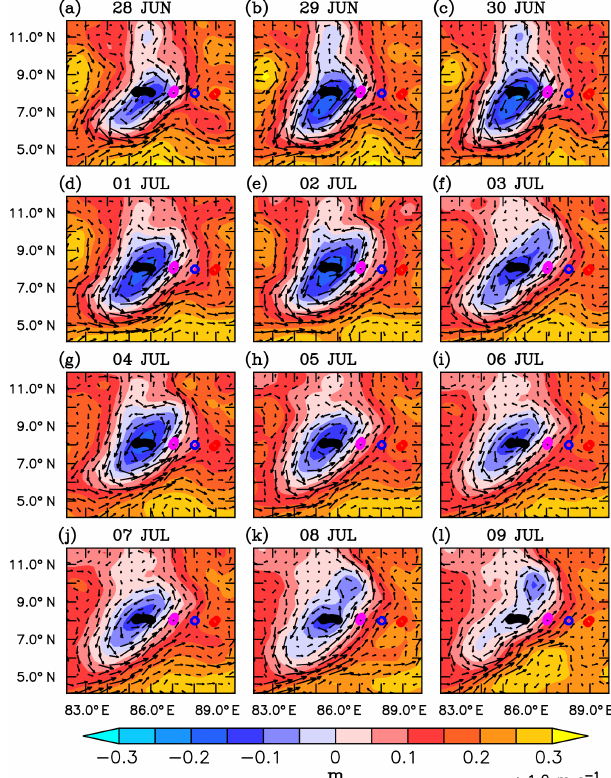
Figure 3. Sea level anomalies (SLAs;m) and surface currents (ms − 1 ) from AVISO for the period 28 June to 9 July 2016. The glider locations are marked along 8 ◦ N (circles). Evolution of Sri Lanka Dome (SLD) is represented by the negative SLAs embedded within the cyclonic